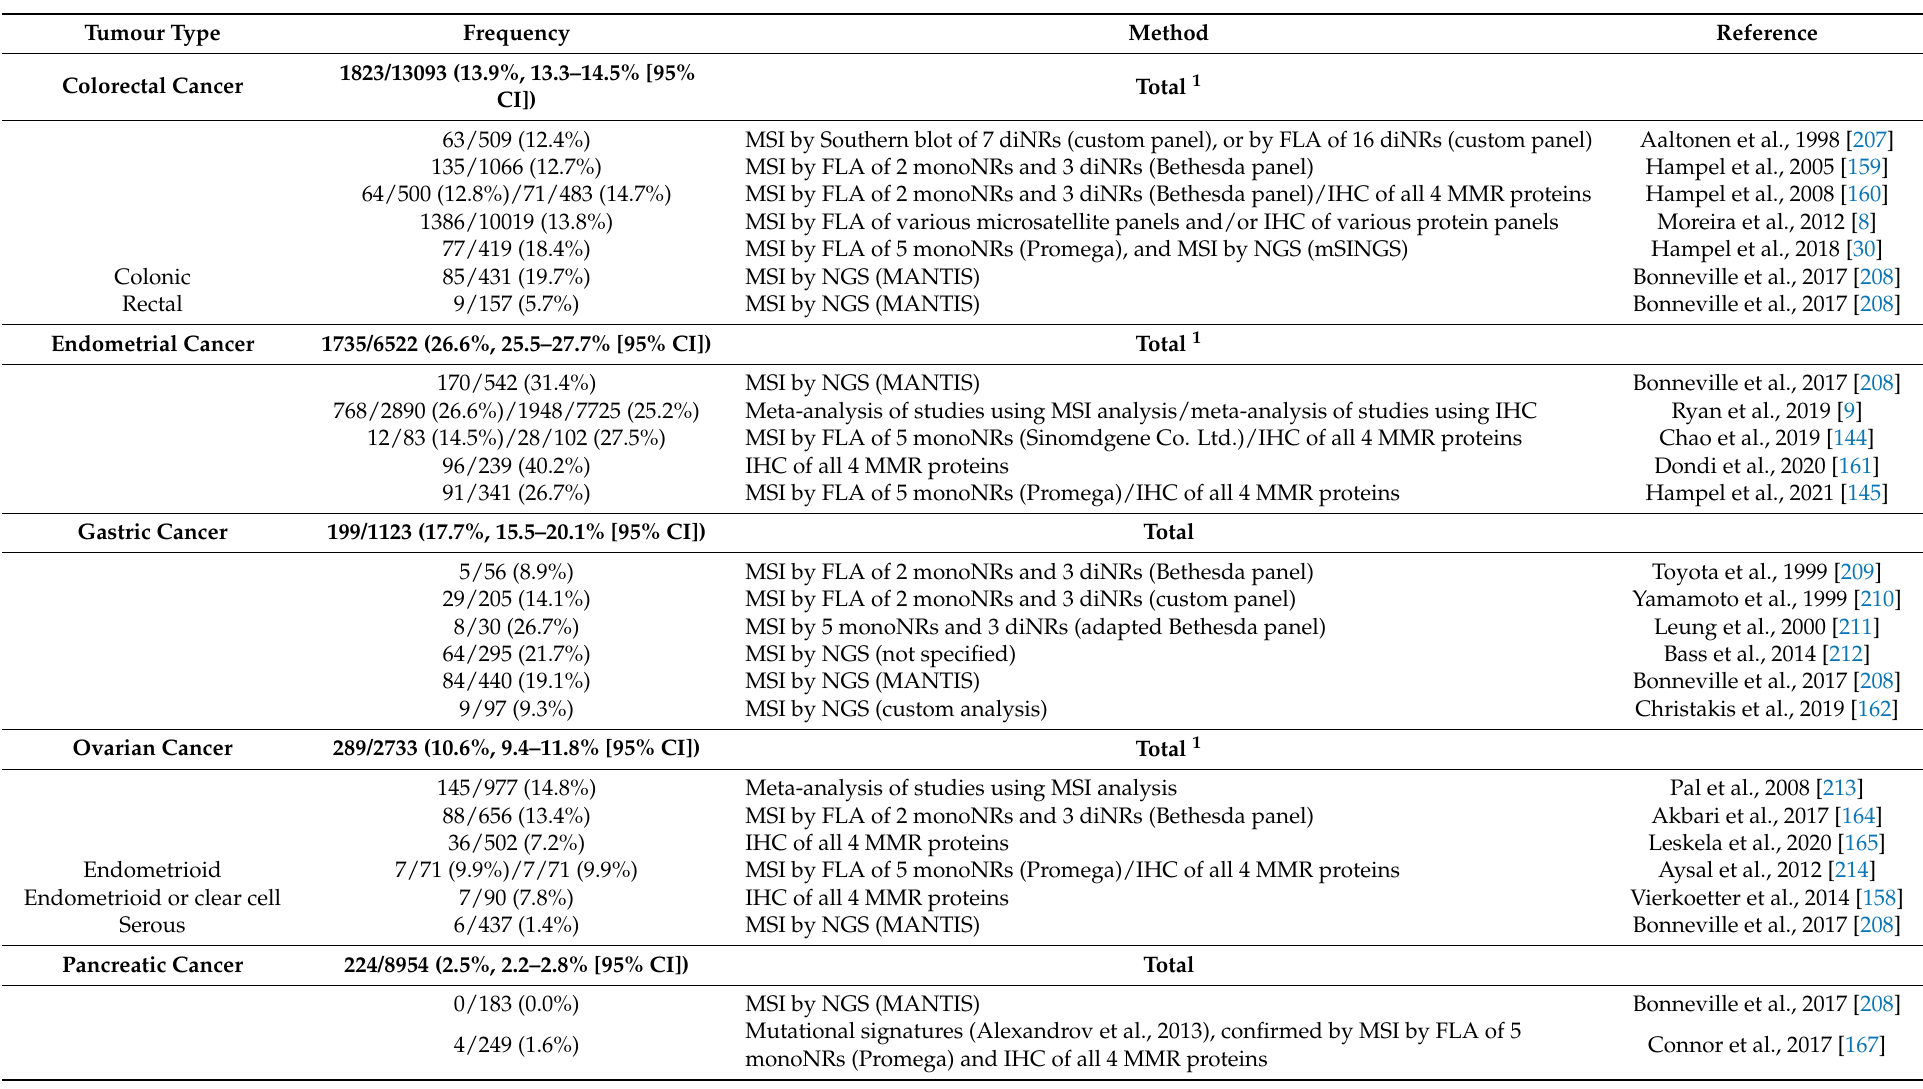
Table 3. Estimated frequency of mismatch repair (MMR) deficiency among unselected tumours of different Lynch-spectrum, and other, tumour types. Unselected means no selection of tumours by the patients’ clinical features, such as age or family